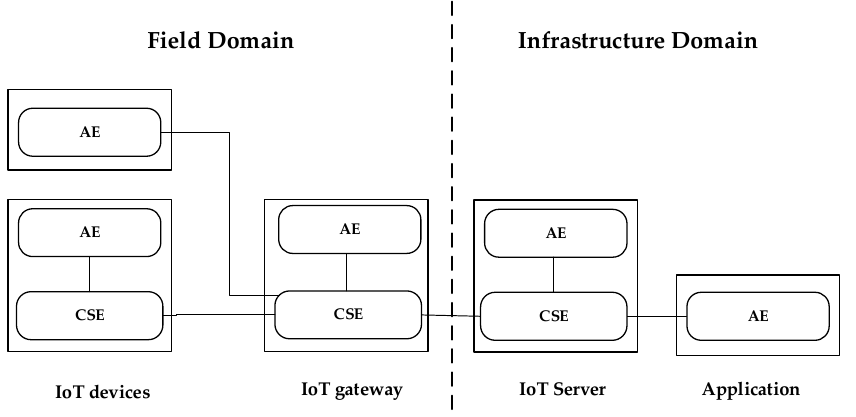
Figure 3. oneM2M Infrastructure and Field Domains.